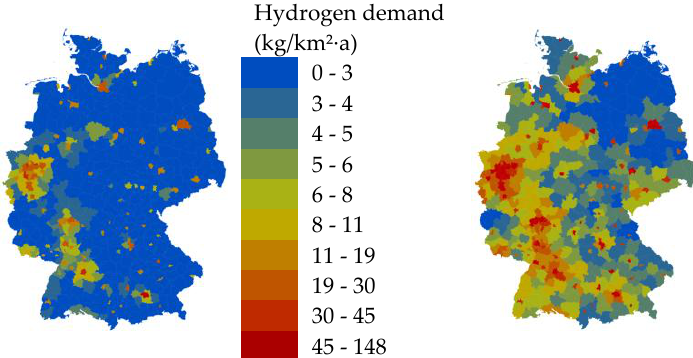
Figure 8. Hydrogen demand in 402 districts according to the model in 2040 ( left ); and 2050 with peak demand of hydrogen ( right ).